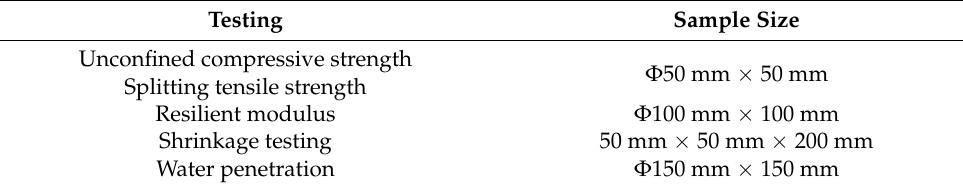
Table 2. Size of